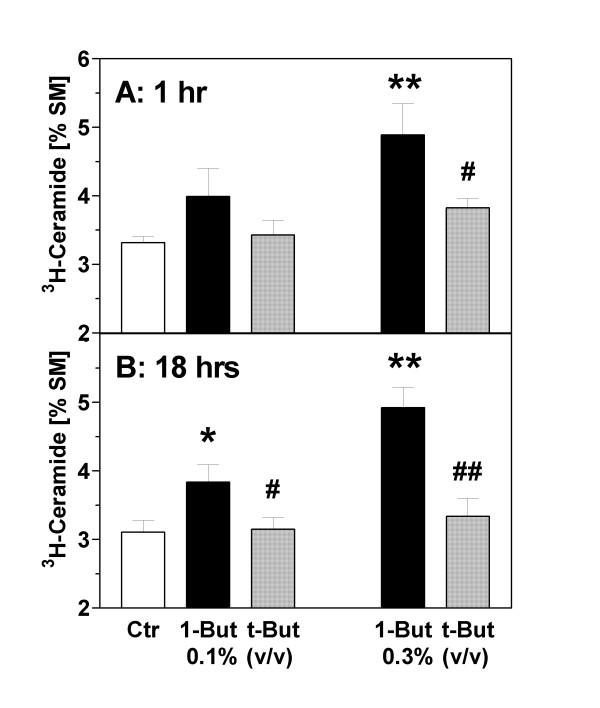
Effects of isomeric butanols on ceramide formation in astrocytes. Astrocytes were prelabeled with [3H]-serine for 72 hours, washed and treated with 1-butanol ("1-But") or t-butanol ("t-But"). After (A) 1 hour and (B) 18 hours, the cells were extracted with methanol/chloroform (2:1), phospholipids were separated by TLC, and the radioactivity associated with ceramide and sphingomyelin was determined by liquid scintillation counting. Data (N = 8–10) are means ± S.E.M. and are expressed as [%] ceramide/sphingomyelin. Statistics: Repeated measures ANOVA, (A) F4,49 = 7.2, p = 0.0002; (B) F4,39 = 25.0, p < 0.0001. *, p < 0.05; **, p < 0.01 vs. controls ("Ctr"). #, p < 0.05; ##, p < 0.01 vs. effect of 1-butanol (Tukey-Kramer multiple comparisons test).